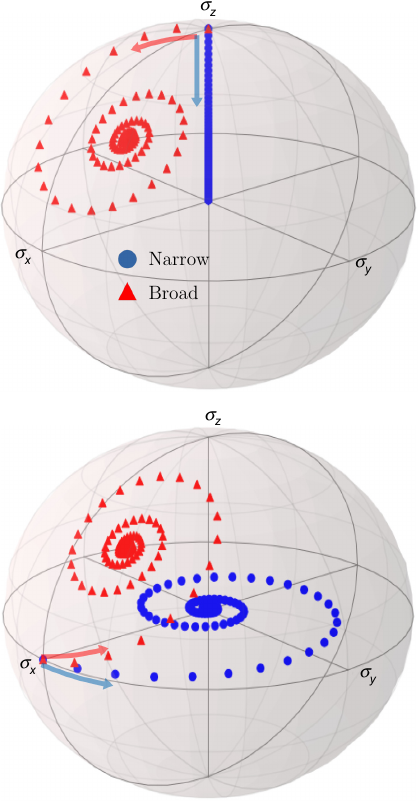
FIG. 3. Bloch sphere representation of the state ρ ( n ) repeated collisions ( n = 200) with narrow and broad Gaussian wave packets (blue circles and red triangles, respectively). The colored arrows show the direction of the evolution of each state in the sphere starting from the initial states, which are pure (i.e., they lie on the surface of the sphere) and given by (ρ Y ) ( 0 ) = 0 (upper panel) and (ρ and (ρ Y ) ( 0 ) 12 panel). All parameters are identical in the two panels, (cid:8) Y = m = 1, p 0 = 10, except the widths, which are σ/( m (cid:8) Y / 2 p 0 ) = 0.2 for narrow wave packets and σ/( m (cid:8) Y / 2 p 0 ) = 20 for broad wave